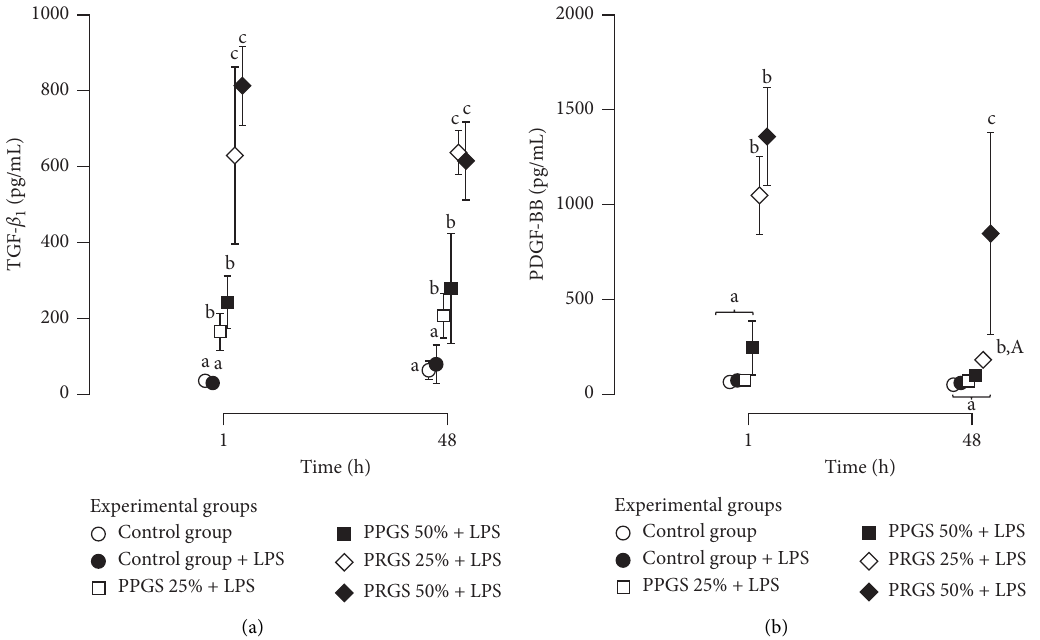
Figure 6: Growth factor concentrations in the culture media of experimental groups at 1 and 48h (a) Mean ( ± SD) TGF- β (pg/mL). (b) Mean ( ± SD) PDGF-BB concentrations (pg/mL). Different lower-case letters represent significant ( P < 0 . 01 ) differences between experimental groups at each independent time. Different capital letters represent significant ( P < 0 . 01 ) differences for the same experimental group at different times. HA, hyaluronan; IL, interleukin; LPS, lipopolysaccharide; PLT, platelet; PDGF-BB, platelet-derived growth factor isoform BB; PPP/PPGS, platelet-poor plasma/platelet-poor gel supernatant; PRP/PRGS, platelet-rich plasma/platelet-rich gel supernatant; TGF- β 1 , transforming growth factor beta 1; WBC, white blood